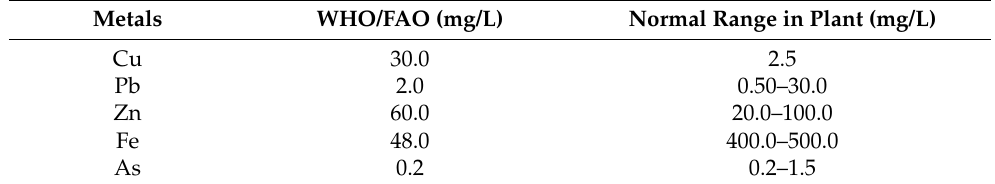
Table 5. Permissible level for heavy metals in food and vegetables according to FAO/WHO